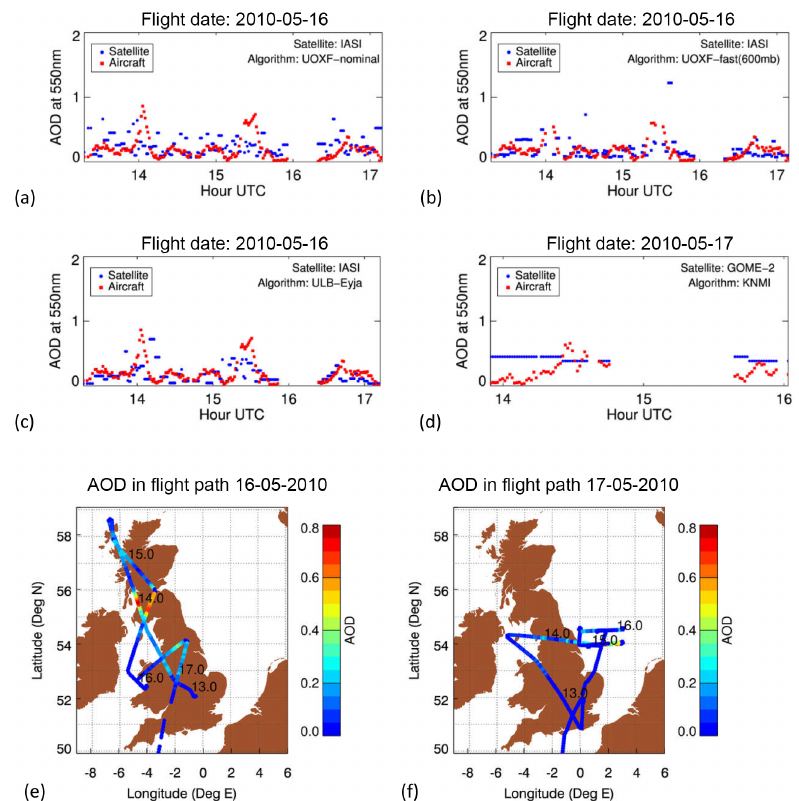
Figure 4. Ash optical depth at 550nm and airborne lidar ash layer optical depth at 355nm as a function of aircraft time. IASI-UOXF products for 16 May 2010 (a, b) , IASI-ULB products for 16 May 2010 (c) and GOME-2A product for 17 May 2010 (d) . The flight tracks for these two days, coloured according to AOD, are shown in panels (e) and (f)